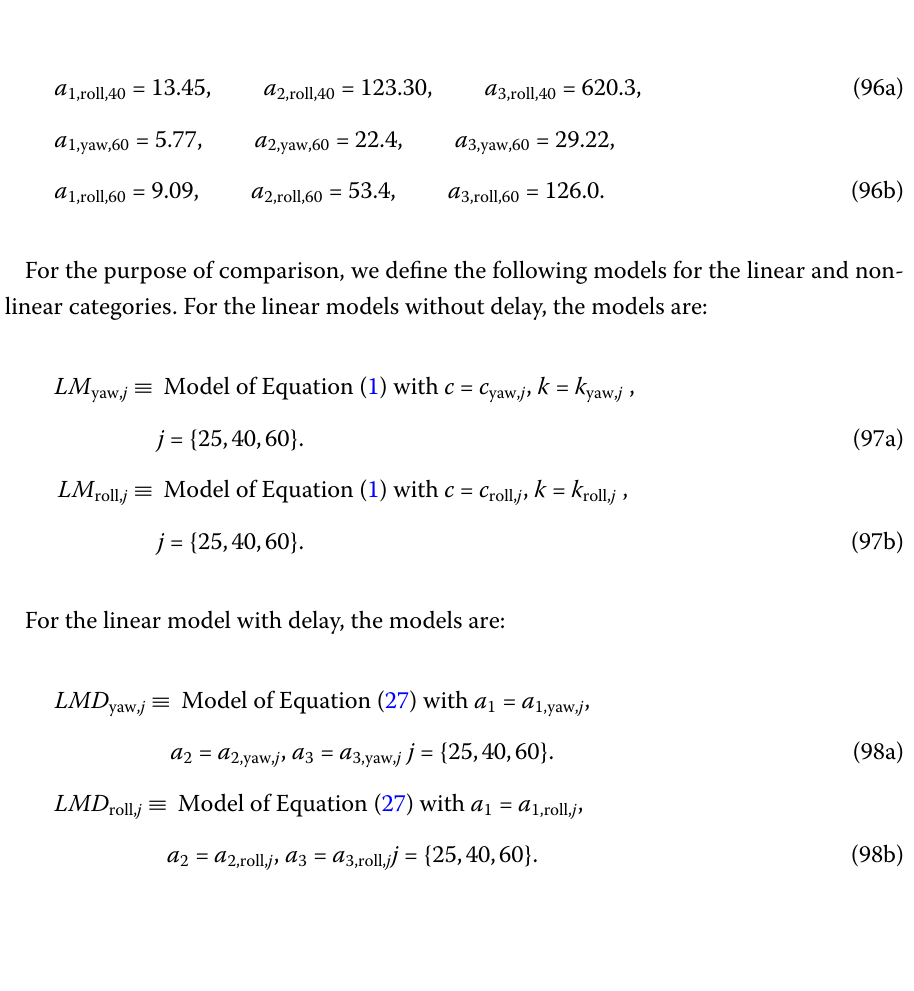
Figure 21 The identified coefficients for the yaw